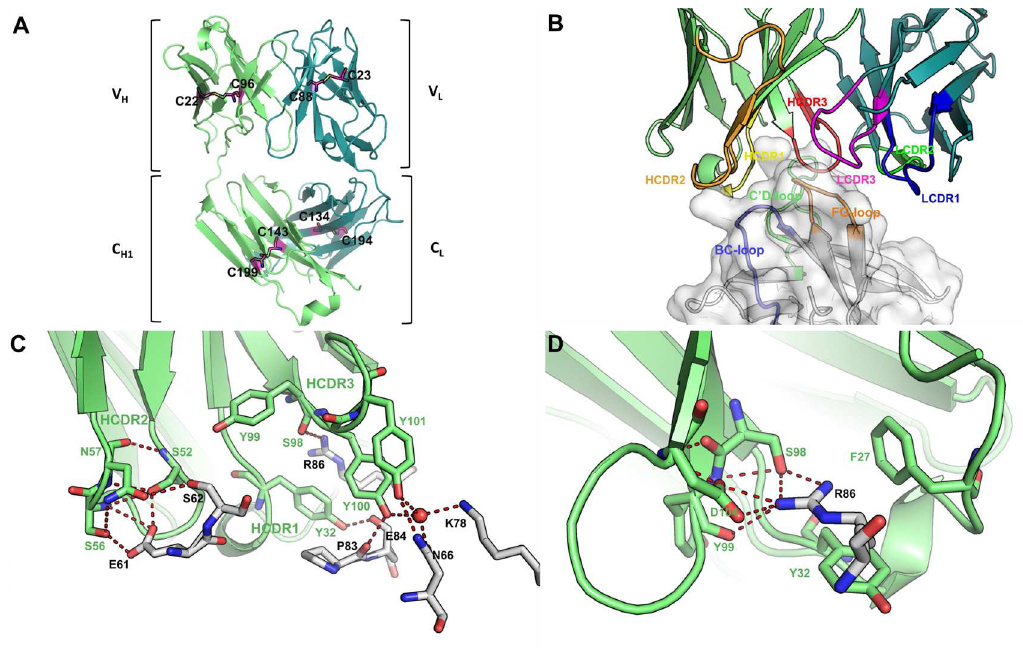
Fig 9. Interaction between HLX10 and hPD-1. (a) HLX10 Fab adopts a typical immunoglobulin fold structure. Heavy chain and light chain are colored in lime and deep teal, respectively. Intra-molecular disulfide bonds are shown in magenta sticks. (b) Side view of binding interface between HLX10 and hPD-1. hPD-1 is represented as surface in white, with BC loop, C’D loop and FG loop in light orange, light blue and light green, respectively. HCDR1, HCDR2 and HCDR3 loops are colored in yellow, orange, and red, respectively, while LCDR1, LCDR2 and LCDR3 loops are colored in blue, green, and magenta, respectively. (c, d) Interaction within interface of CDRs loop of heavy chain and hPD-1. Arg86 of hPD-1 is involved in several hydrogen bonds and salt bridges with